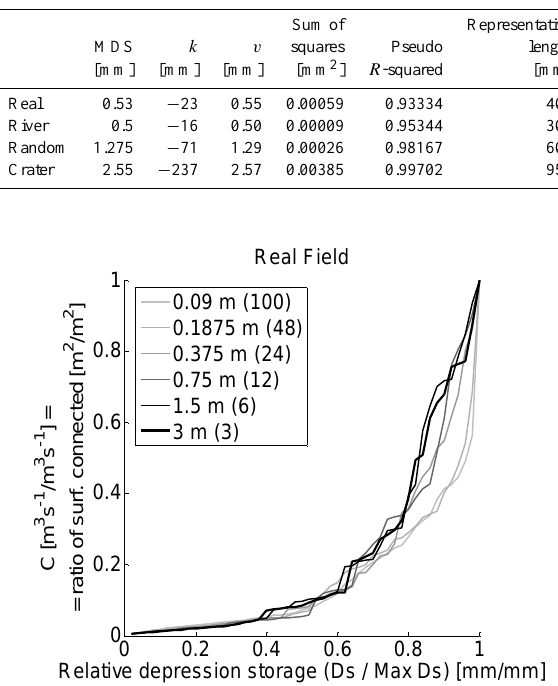
Fig. 5. Real field – effect of plot width on the normalized RSC function. Depression storage (x-axis) was scaled by the maximum depression storage. The numbers in parentheses indicate the number of connectivity curves used for calculating the average normalized RSC functions. All the plots are 3m long.